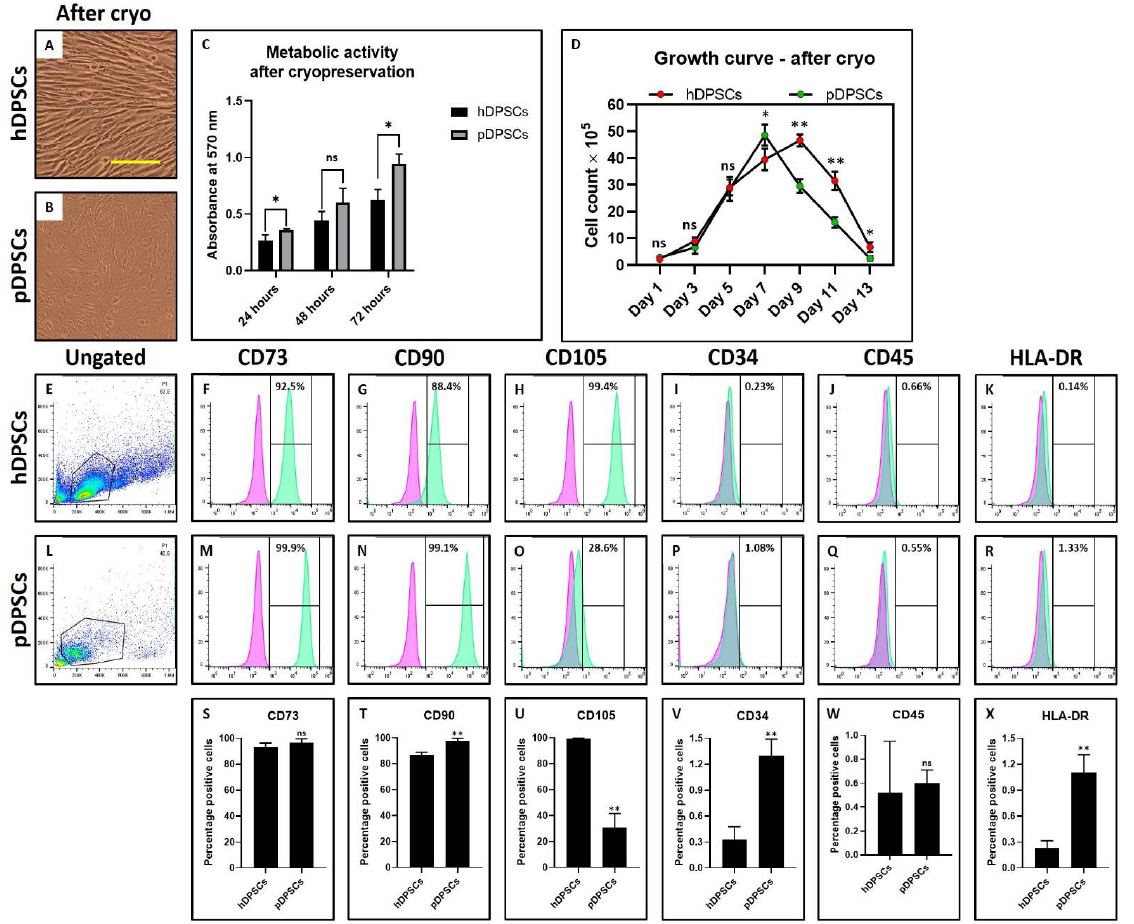
Figure 5. Assessment of morphology, metabolic activity and MSC markers in DPSCs from healthy and periodontitis-affected teeth after cryopreservation. ( A , B ) photomicrograph showing the morphology of hDPSCs and pDPSCs at Passage 6. Scale bar = 100 µm. ( C ) comparative analysis of the metabolic activity in hDPSCs and pDPSCs at 24, 48 and 72 h. ( D ) comparative analysis of cellular growth in hDPSCs and pDPSCs. ( E – X ) comparative analysis of MSC-specific cell surface maker analysis for CD73, CD90, CD105, CD34, CD45 and HLA-DR in hDPSCs and pDPSCs. Experiments were repeated in triplicates for n = 3. ns: not significant, * p < 0.05 and ** p < 0.01. hDPSCs: dental pulp stem cells from healthy teeth and pDPSCs: dental pulp stem cells from periodontitis-affected teeth.3.6. pDPSCs Demonstrate Increased Migration,